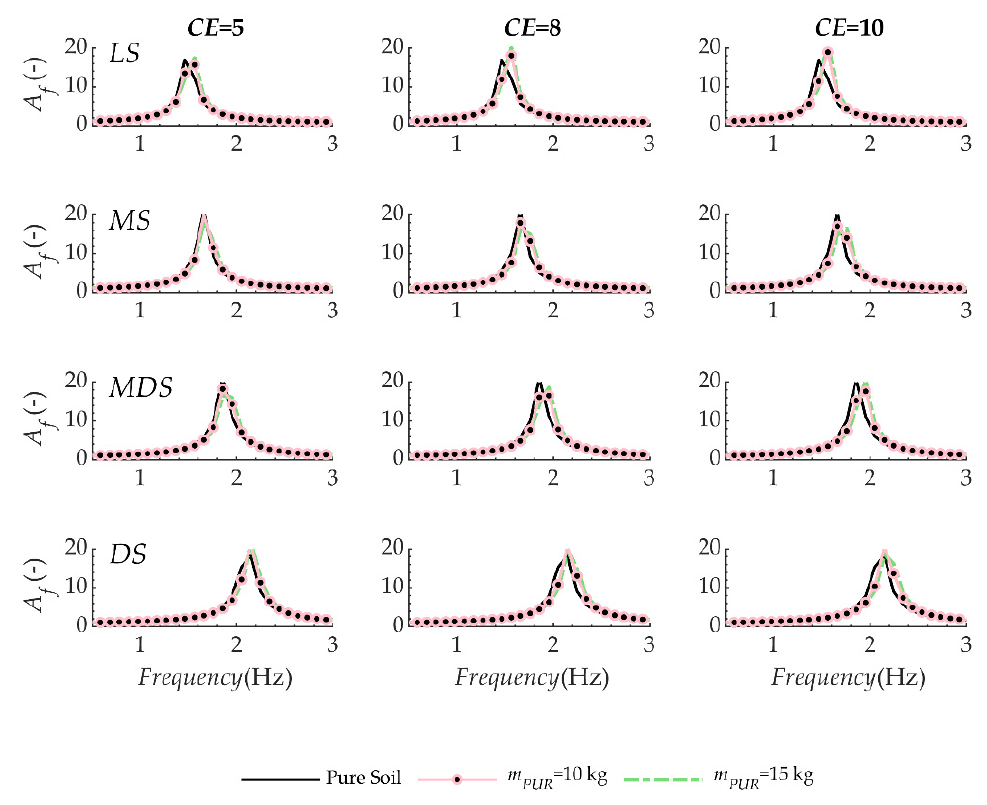
Figure 13. Amplification functions for h = 3 m and m PUR = 10 and 15 kg.